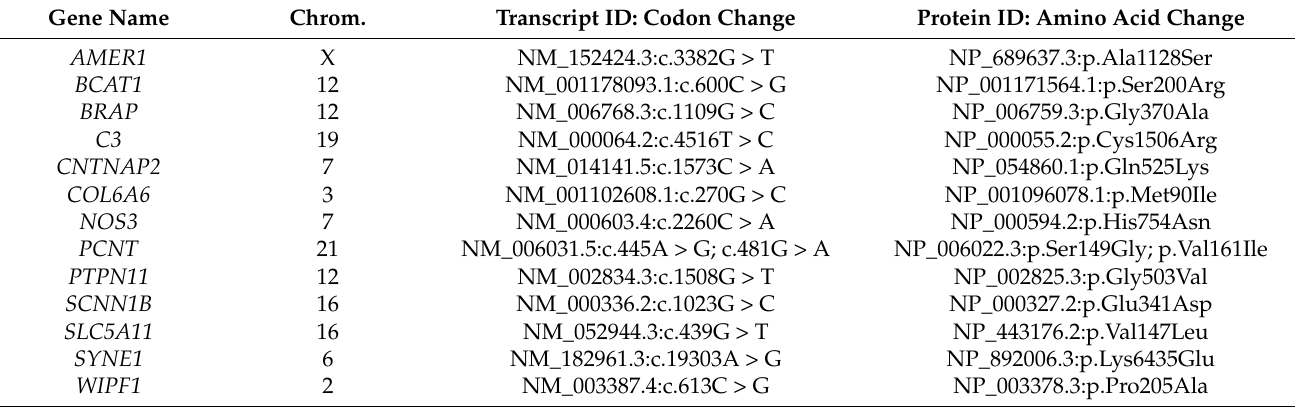
Table 1. Identification of 14 heterozygous mutations of 13 cancer- and other disease-related